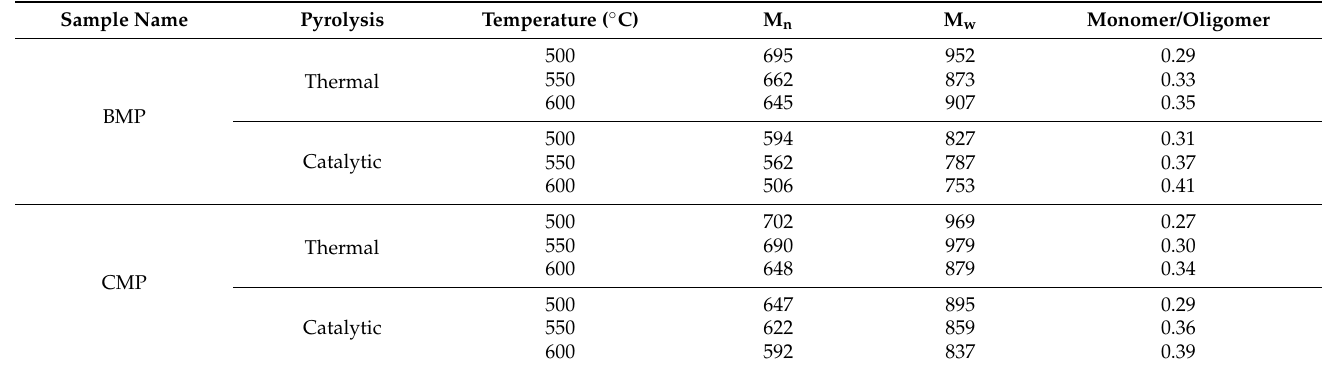
Table 6. Weight (M w ) and number (M n ) average molar mass of thermal pyrolysis and catalytic pyrolysis of BMP and CMP at 500, 550, and 600 ◦ C were determined from positive ion ESI-MS